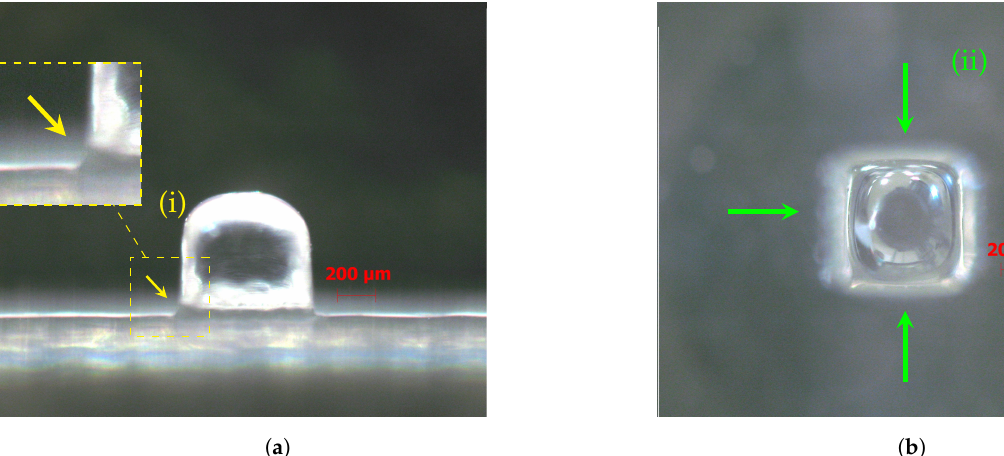
Figure 5. Specimen S06 detail. ( a ) Side view, ( i ) excess material in the specimen base; ( b ) top view, ( ii ) outside double perimeter outline. For details about the conditions of the images taken, see Section